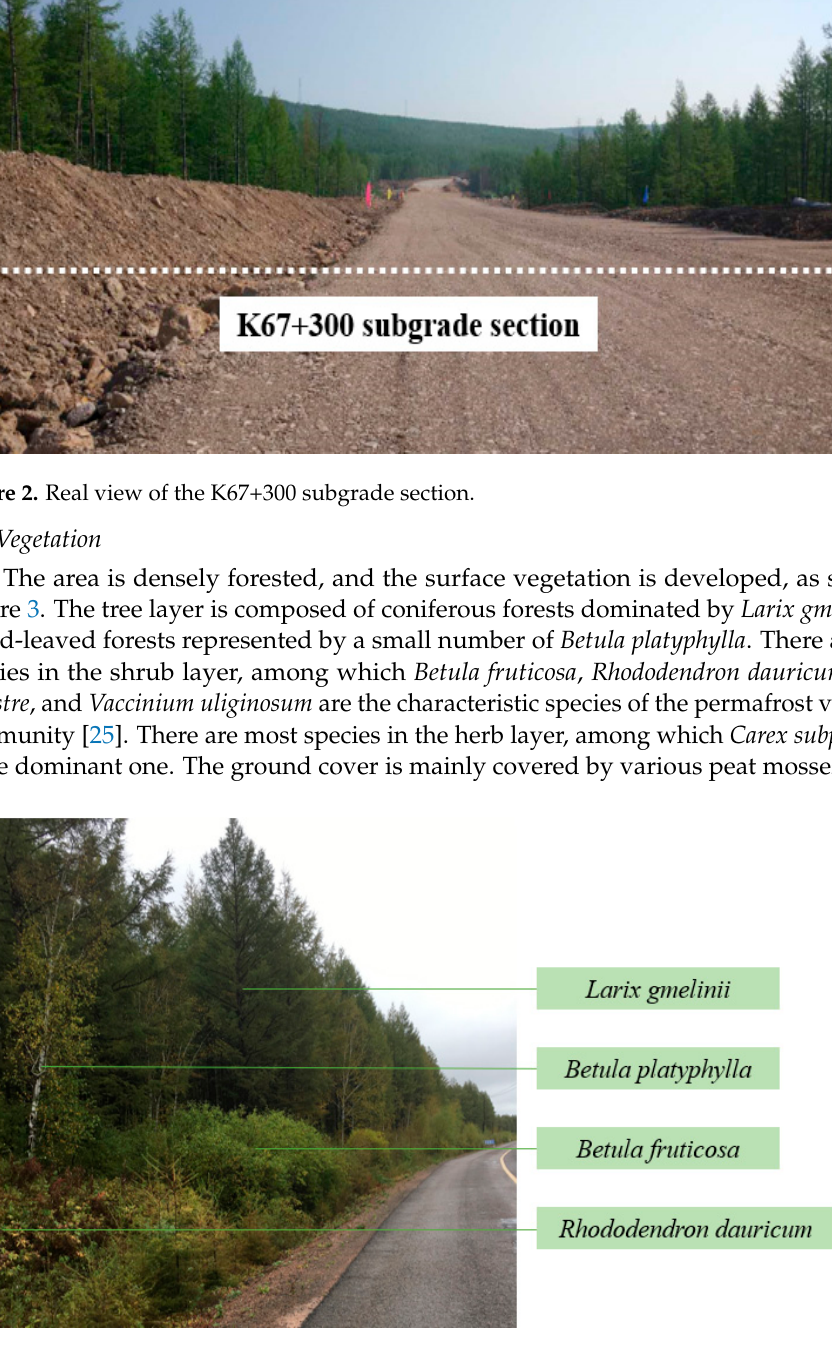
Figure 3. Larch forest cover of K67+300 subgrade section.